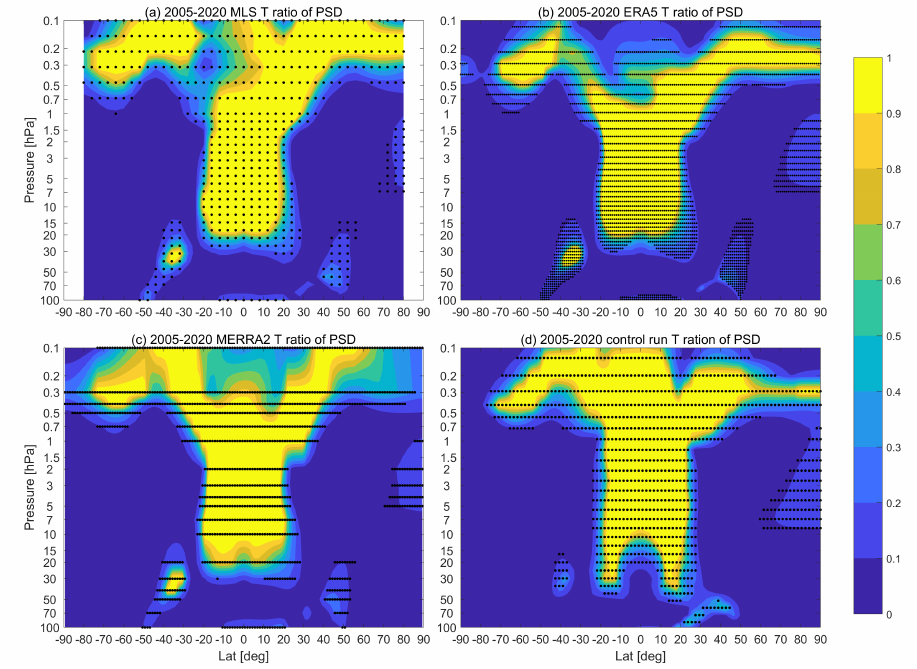
Figure 2. The ratio between SAO and maximum PSD based on MLS ( a ), ERA5 ( b ), MERRA2 ( c ) and model simulation ( d ) in the period 2005–2020. The dots mark the SAO significant area with an FDR level of